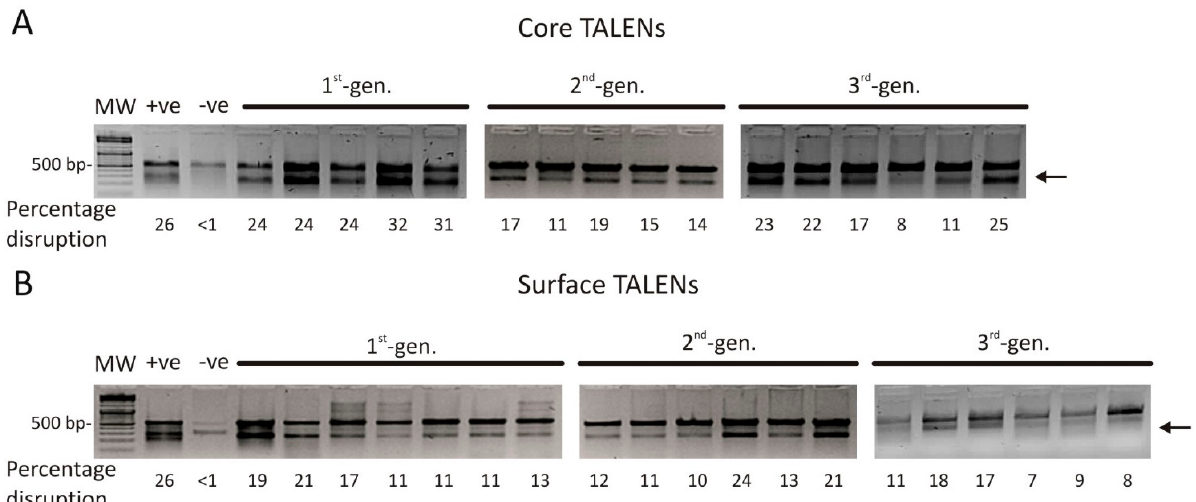
Figure 4. Targeted disruption of HBV-encoding DNA in murine liver samples by TALENs. To determine the levels of targeted mutagenesis mediated by the TALENs in vivo, we extracted total DNA from murine livers and C ( A ) and S ORF ( B ) target sites were amplified by PCR. PCR amplicons were subjected to CelI cleavage assay. Arrows depict on-target cleavage. MW: molecular weight marker, +ve: HBx heteroduplexes, − ve: mock.